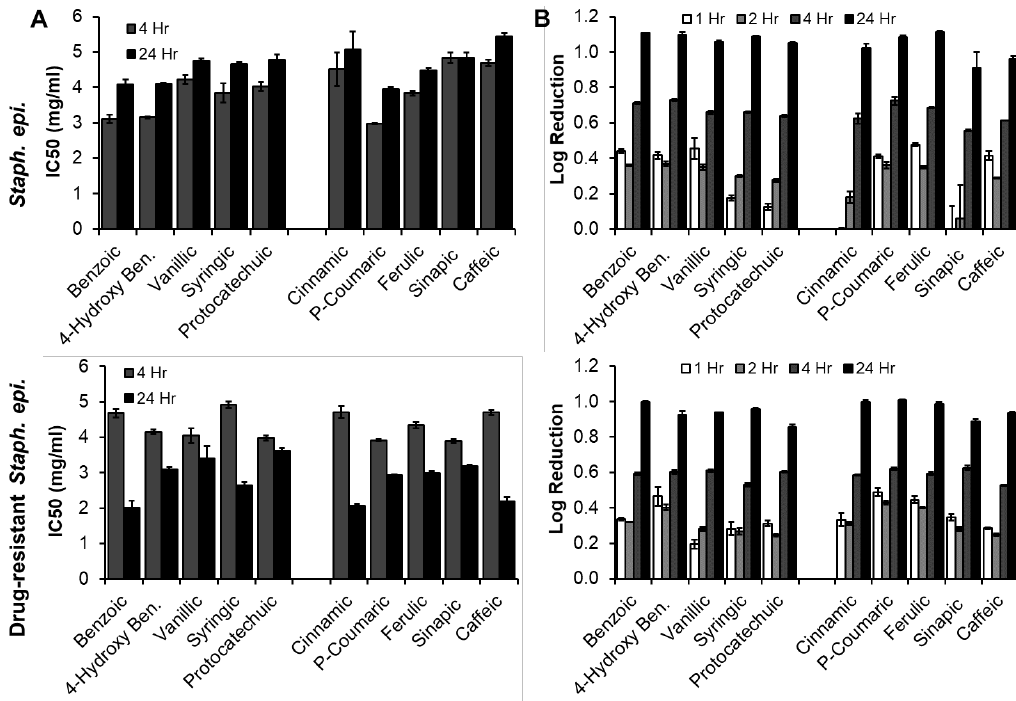
Figure 5. ( A ) IC50 and ( B ) log reduction of PAs against Staph. epi. (top row) and drug-resistant Staph. epi (bottom row) . n = 3, mean ± standard deviation displayed.